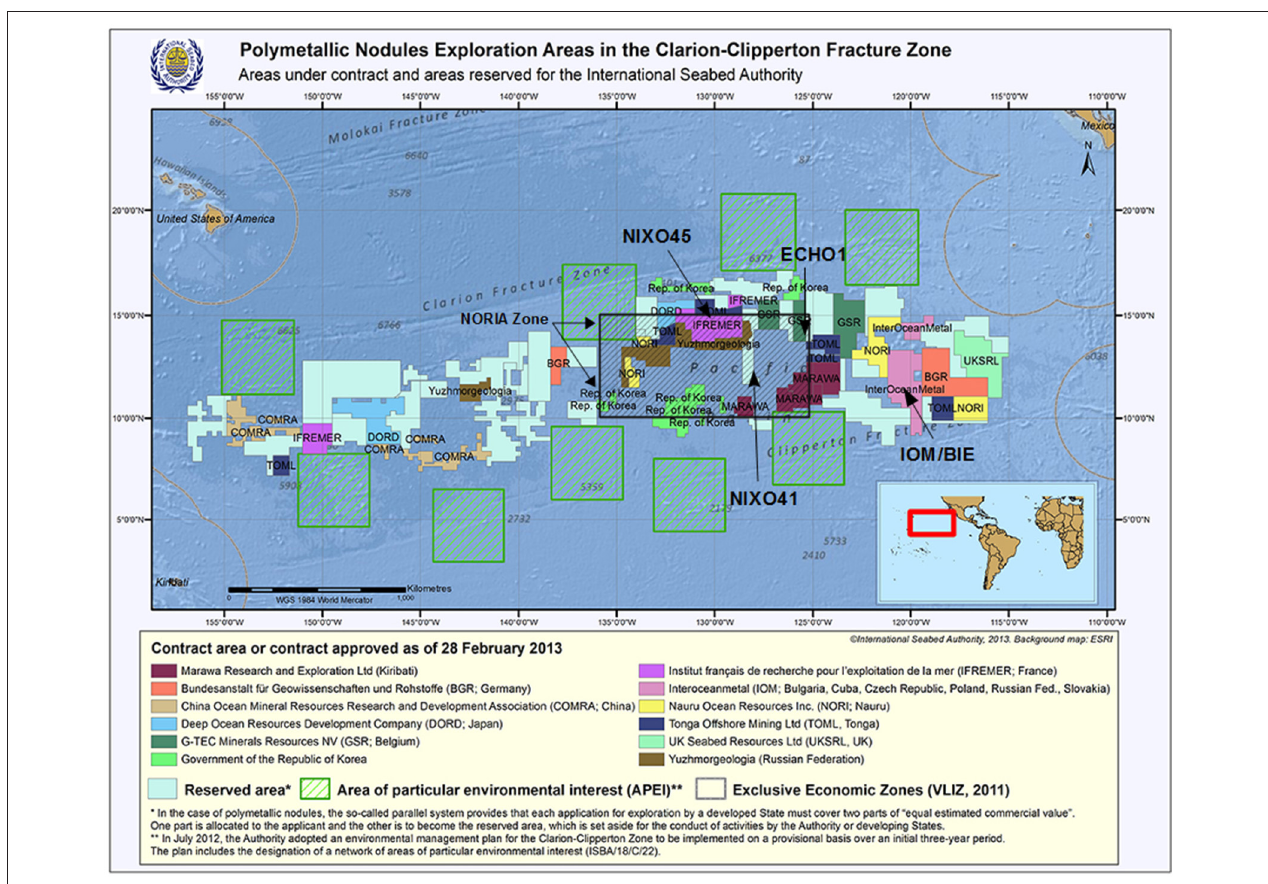
FIGURE 2 | Updated map adapted from https://www.isa.org.jm of the CCZ showing the areas under contract and the areas reserved for the International Seabed Authority, as well as the Areas of Particular Environmental Interest (APEI) and the UNESCO/IOC Baseline Study areas (NORIA, NIXO 45, NIXO 41, Echo 1, IOM BIE).